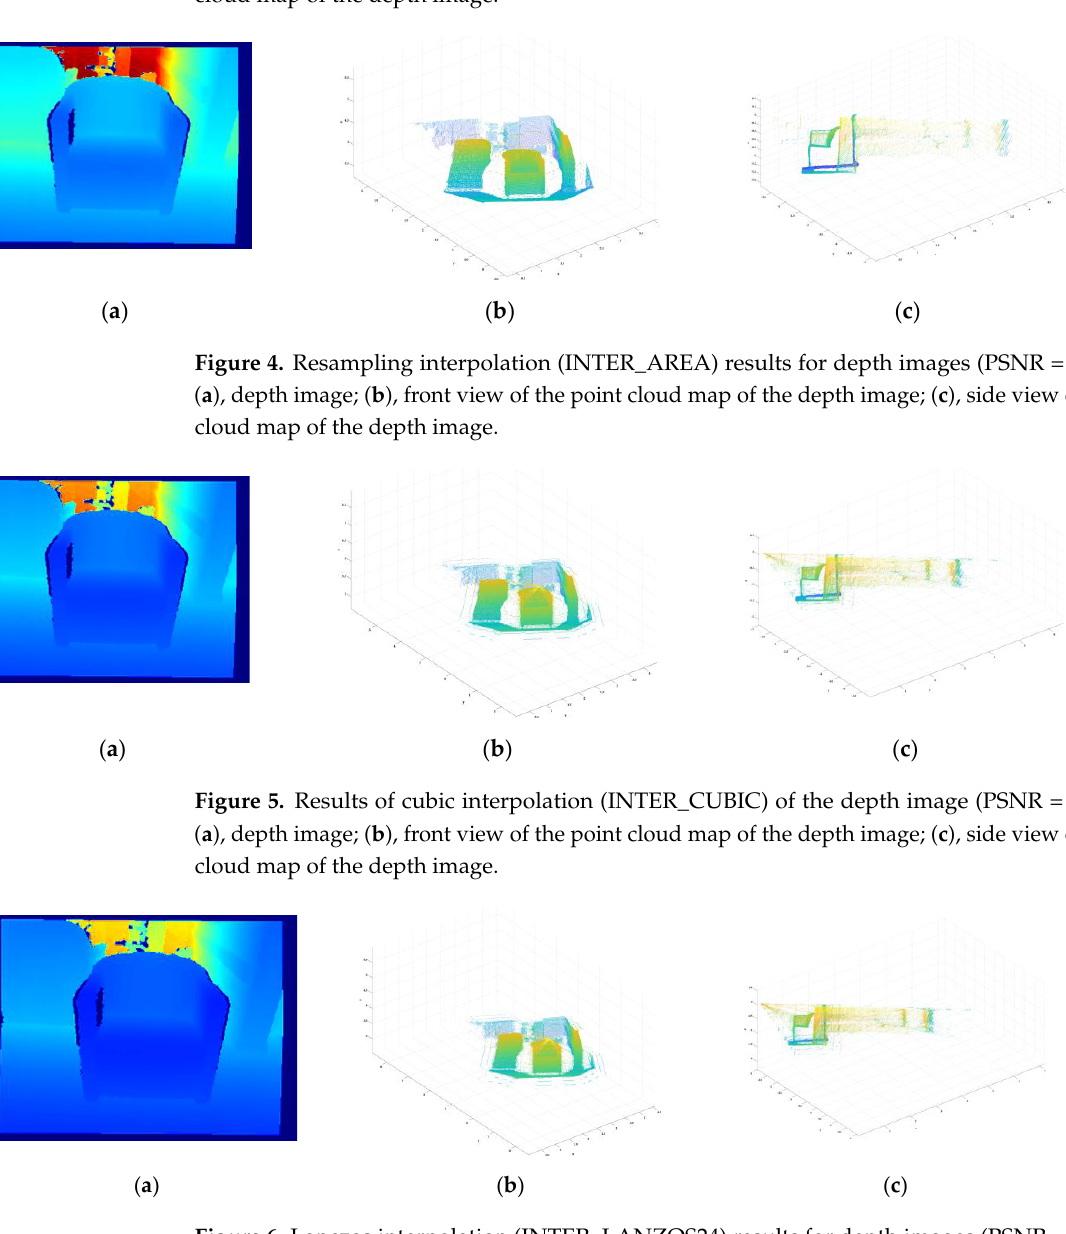
Figure 3. Bilinear interpolation (INTER_LINEAR) results for depth images (PSNR = 34.164 dB). ( a ), depth image; ( b ), front view of the point cloud map of the depth image; ( c ), side view of the point cloud map of the depth image.